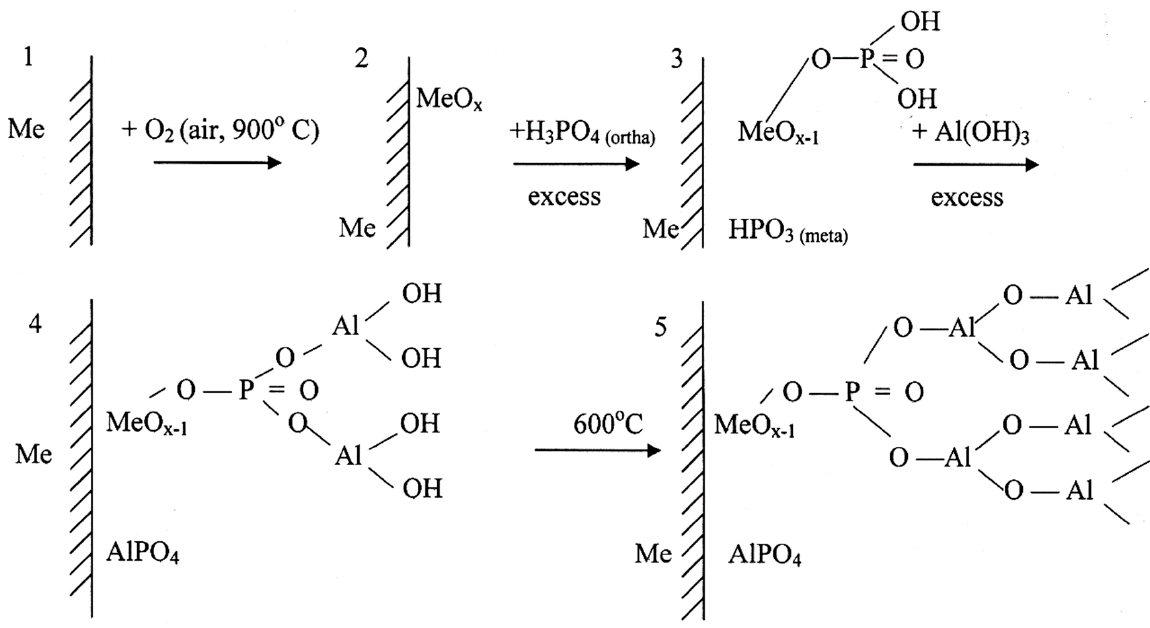
Figure 6. Scheme of the stages (1–5) of the process of phosphating and supporting aluminum oxide on the pre-oxidized surface of the Fe-Cr-Al foil.